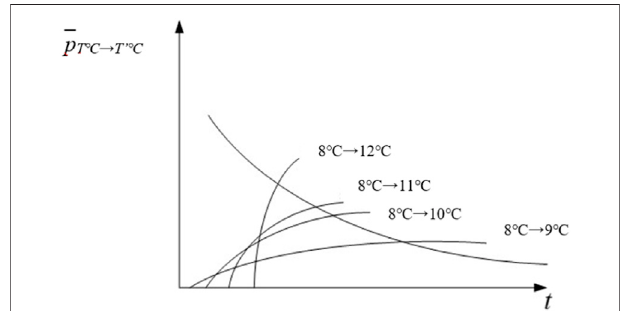
FIGURE 3 | Output characteristic points of CAC virtual unit.